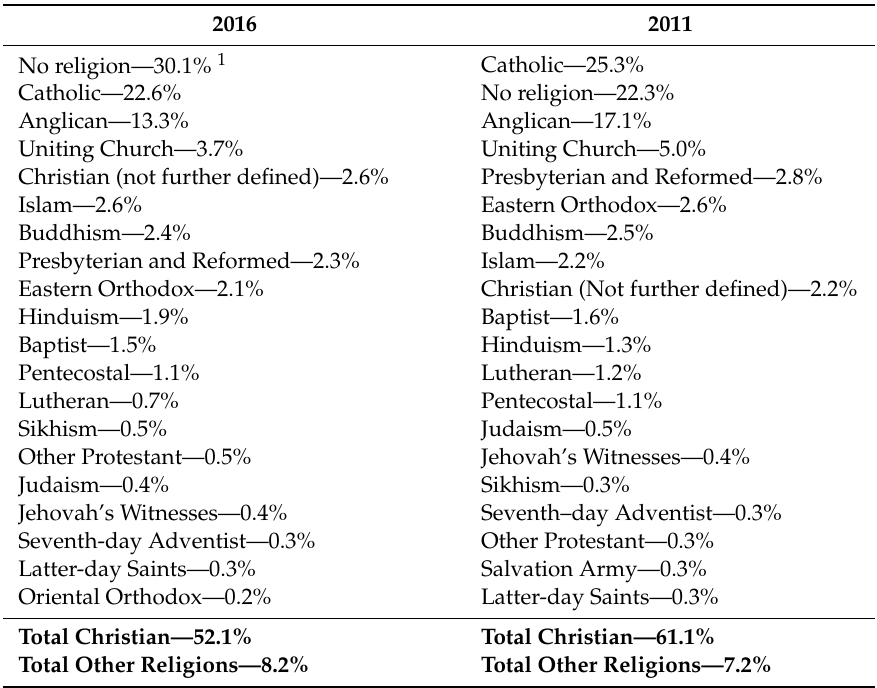
Table 1. Top 20 religions in Australia in 2016 and